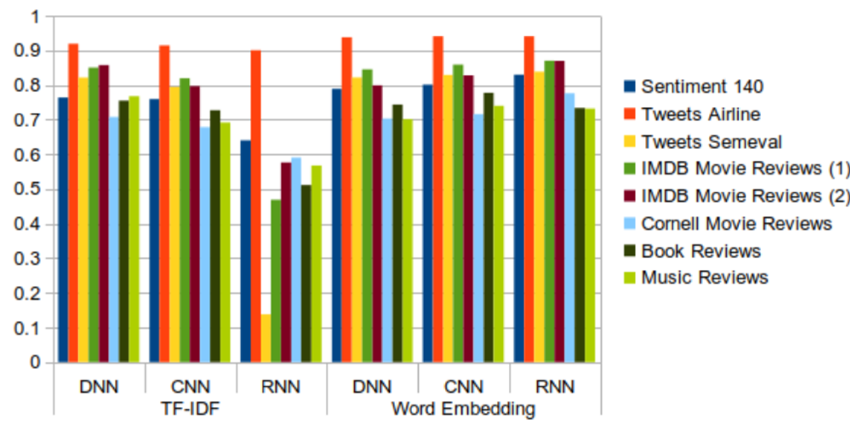
Figure 19. F-score values of DNN, CNN, and RNN models with TF-IDF and word embedding for Electronics 2020 , 9 , x FOR PEER REVIEW different datasets. Table 6. The AUC comparison for different datasets.